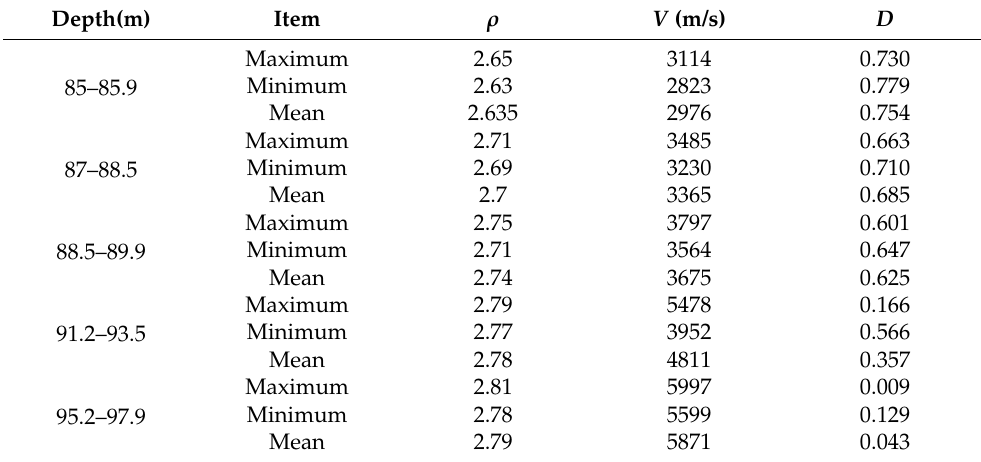
Table 4. Range and mean deviation values of the density, longitudinal wave speed and initial damage.